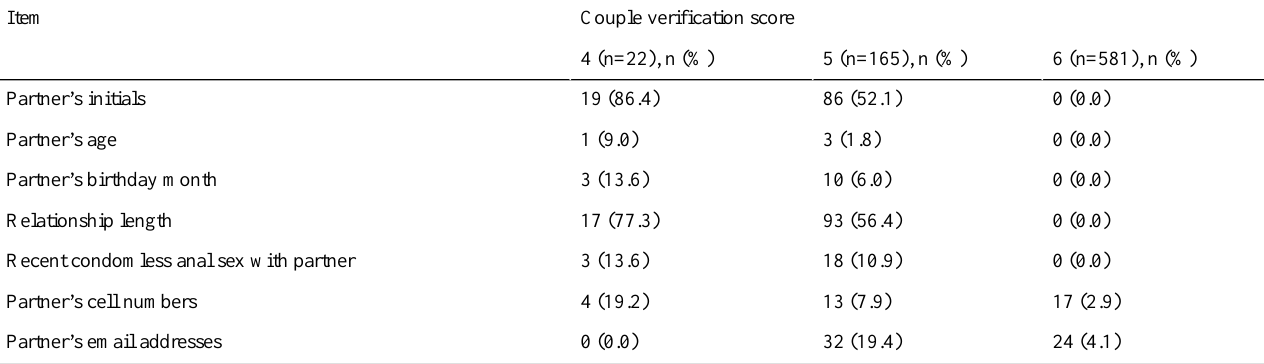
Table 2. Proportion and identification of eligibility screening items that did not pass the verification test, by couples’passing verification score. Couple verification